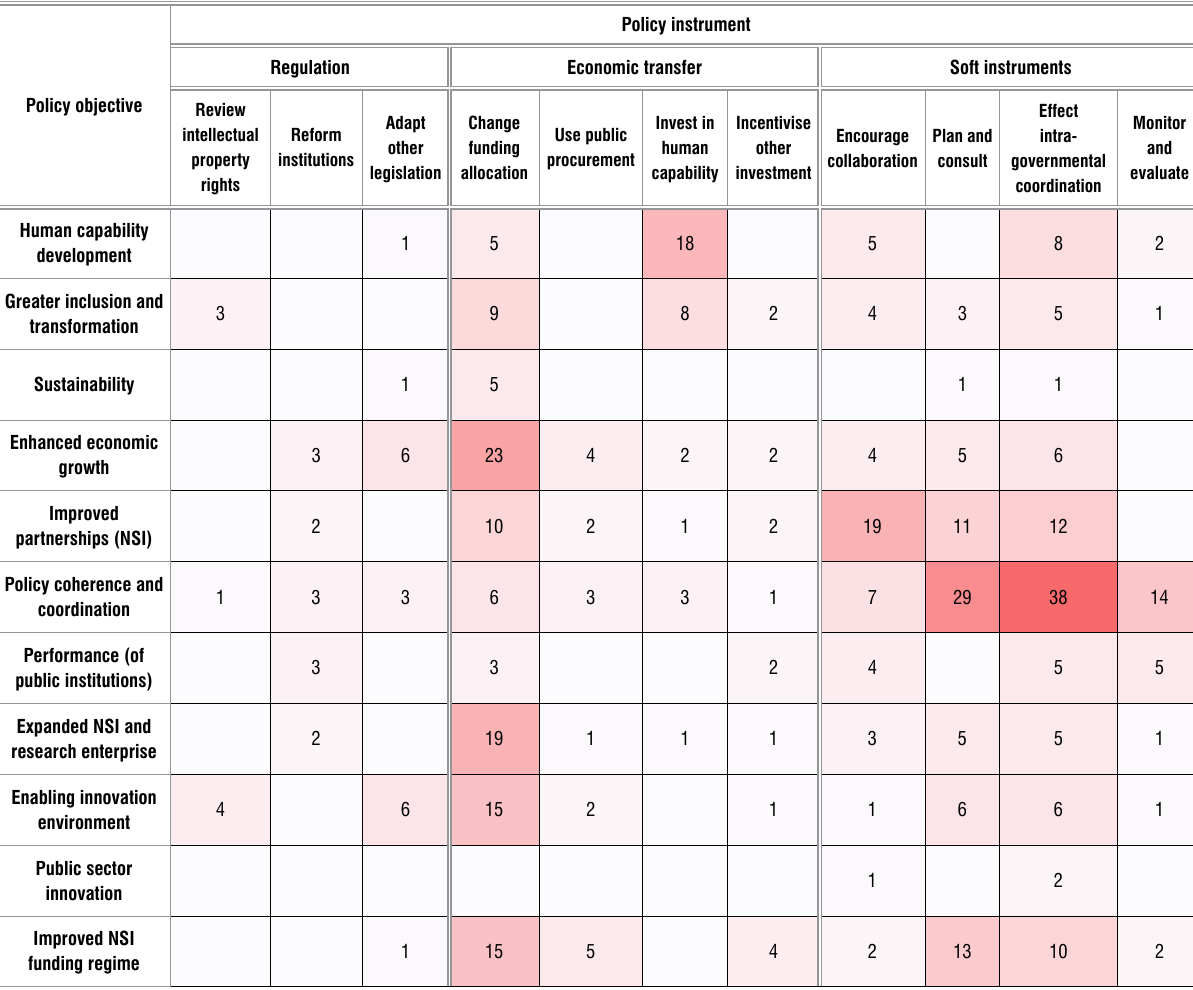
table 1: The policy matrix of the Draft White Paper, constructed using the conventional categories for policy instruments 5